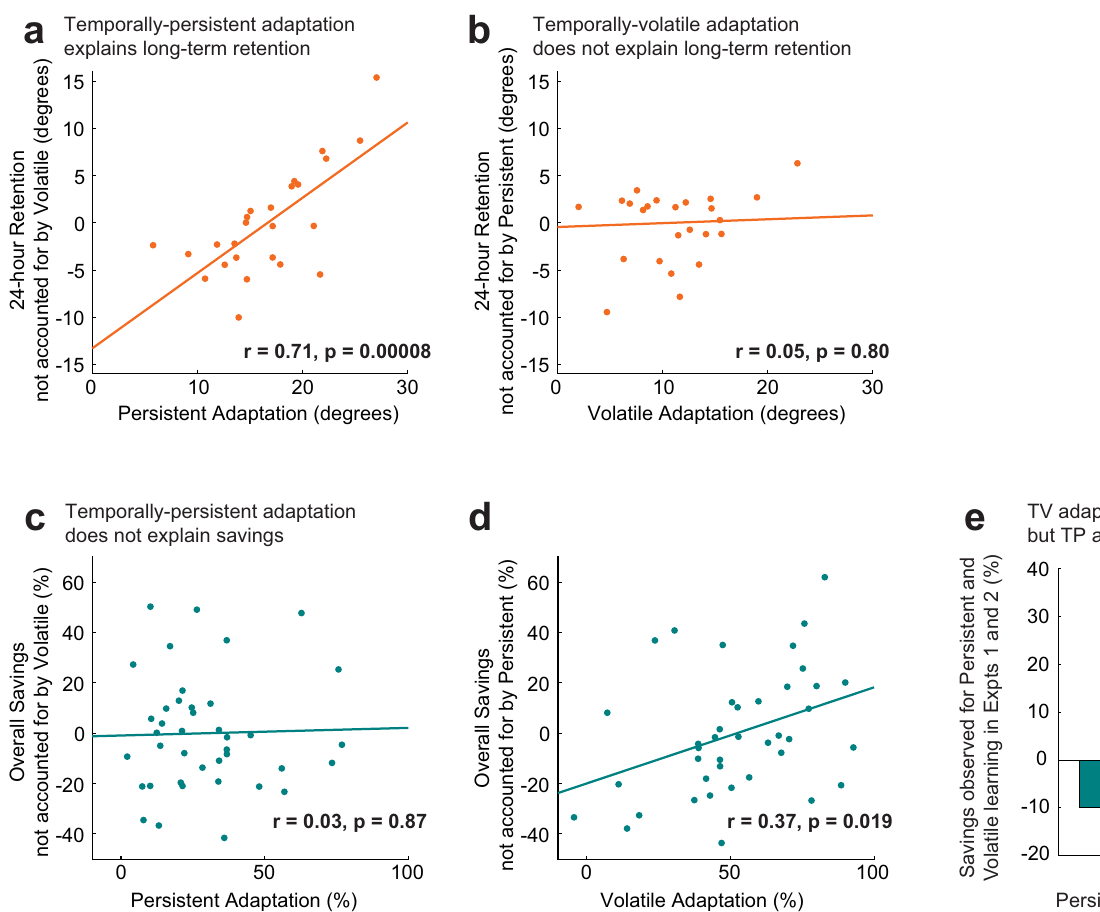
Fig 6. A double dissociation between savings and long-term memory, uncovered by dissection of learning into temporally-persistent and temporally- volatile components. (a) Illustration of the partial regression between temporally-persistent adaptation on day 1 (shown on x-axis) and 24-h retention across individuals ( N = 25). The y-axis represents residuals of the univariate regression of 24-h retention upon temporally-volatile adaptation. The positive relationship indicates that higher temporally-persistent adaptation is associated with higher long-term memory. The solid line indicates linear fit. (b) Same as a but for temporally-volatile adaptation, showing no significant relationship (slopes restricted to positive values). (c) Illustration of the partial regression between temporally-persistent adaptation during relearning (shown in x-axis) and savings for early (trials 2–6) training combined across Experiments 1 and 2. The y-axis represents residuals of the univariate regression of savings upon temporally-volatile adaptation. There is no significant relationship. (d) Same as c but for temporally-volatile adaptation, showing a significant positive relationship and thus indicating that temporally-volatile adaptation explains overall savings. Note that mean y-axis values in (a)–(d) are zero, since they represent residuals of linear regression; these values do not reflect the actual amounts of long-term retention or savings which are, on average, significantly above zero. (e) Comparison of average savings for temporally-persistent (TP) and temporally-volatile (TV) adaptation, combined across Experiments 1 and 2. Error bars indicate SEM. *** p < 0.001. Underlying data supporting this figure can be found in files Exp_1_2_data.mat and Exp_4_data.mat.